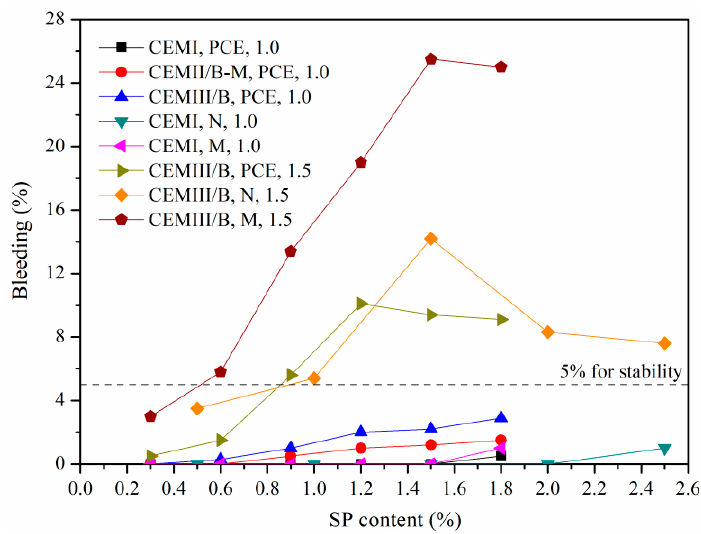
Figure 8. Effect of SP content and cement type on bleeding rates of fresh SMCG at W/S of 1.0 and 1.5.